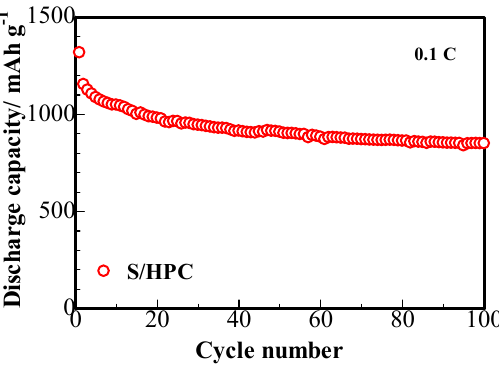
Figure 7. Cycling performance of S/HPC composite cathode at 0.1 C.